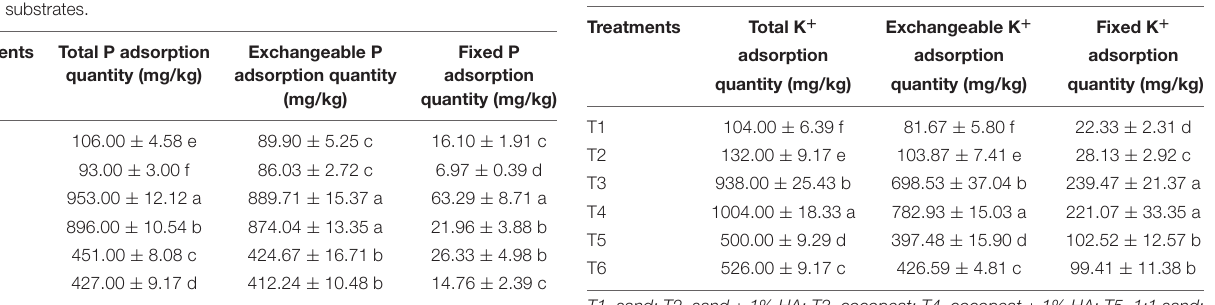
FIGURE 6 | Relationships between the concentrations of KCl solution added and the total K adsorption quantity. T1, sand; T2, sand + 1% HA; T3, cocopeat; T4, cocopeat + 1% HA; T5, 1:1 sand: cocopeat; T6, 1:1 sand: cocopeat + 1% HA. TABLE 7 | Effects of 1% HA addition on potassium storage capacity of different